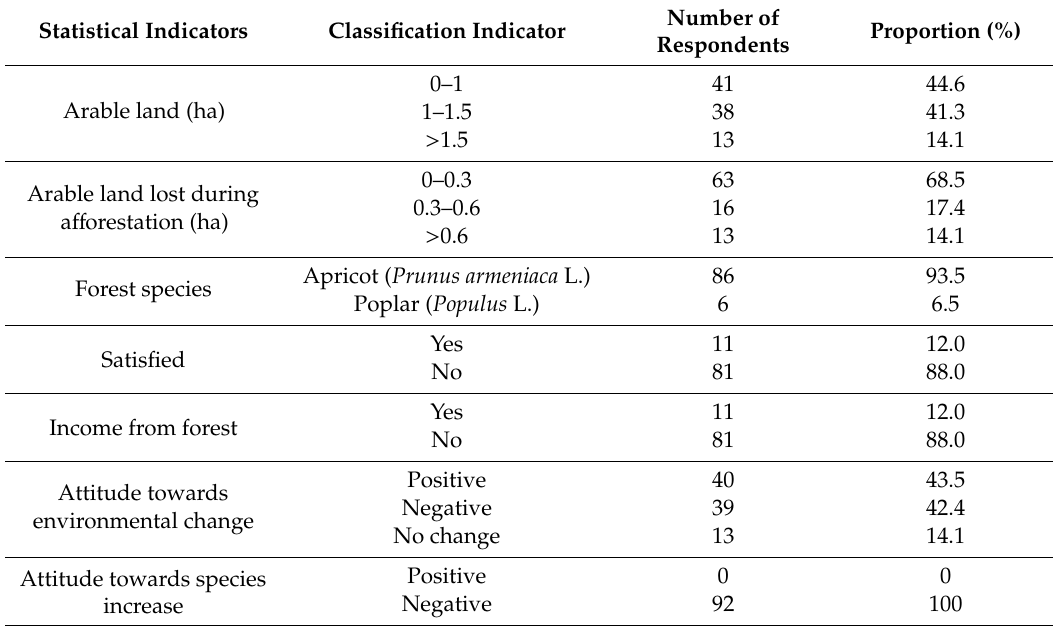
Table 2. Respondent land resource information and environmental